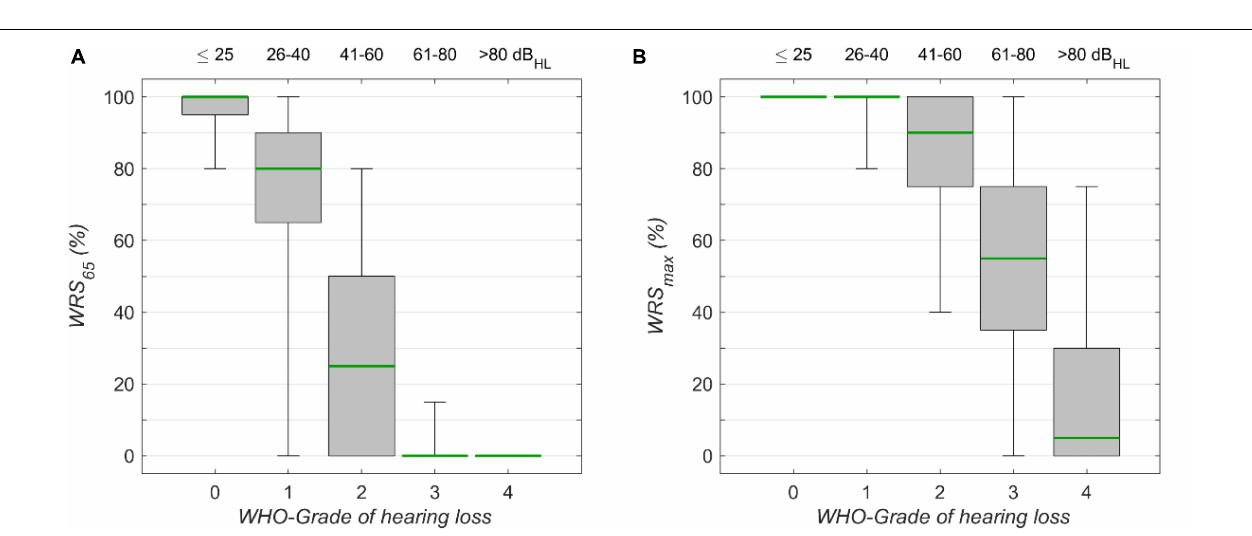
FIGURE 2 | Distribution of 19,801 cases with respect to age for different WHO grades of hearing loss. Corresponding 4FPTA ranges are shown on the upper x-axis.